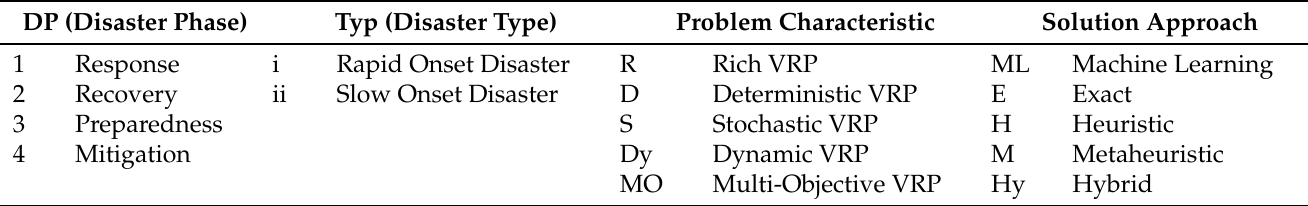
Table 3. Abbreviation for Tables (in Appendix